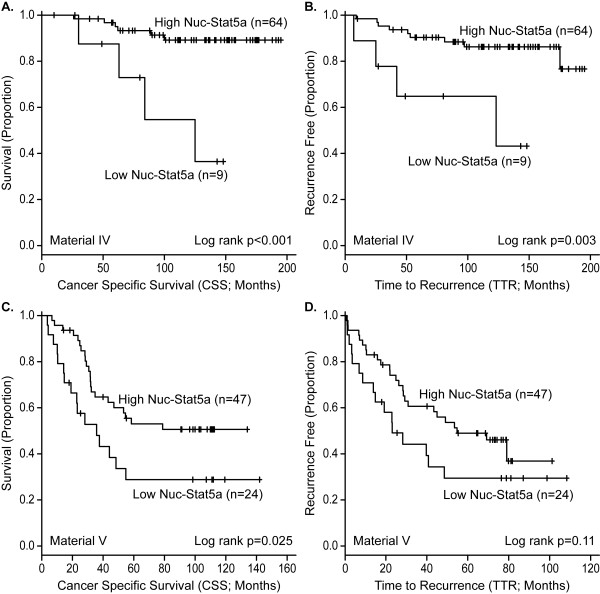
Low levels of nuclear Stat5a (Nuc-Stat5a) predict poor response to antiestrogen therapy. (A, B) Nuc-Stat5a was detected by DAB-chromogen IHC and pathologist scoring of whole-tissue sections from node-negative breast cancer patients treated with antiestrogen monotherapy (Material V). The lack of nuclear localization of Stat5a predicted (A) poor breast cancer-specific survival (CSS) and (B) reduced time-to-recurrence (TTR) of breast cancer. (C, D) Nuc-Stat5a expression levels were measured with immunofluorescence and quantified with AQUA in node-negative and -positive breast cancer patients treated with antiestrogen monotherapy (Material VI). Low levels of Nuc-Stat5a were predictive of (C) poor cancer-specific survival (CSS) and (D) reduced TTR of breast cancer. Kaplan-Meier plots with censored cases (+) and number of patients per group indicated.